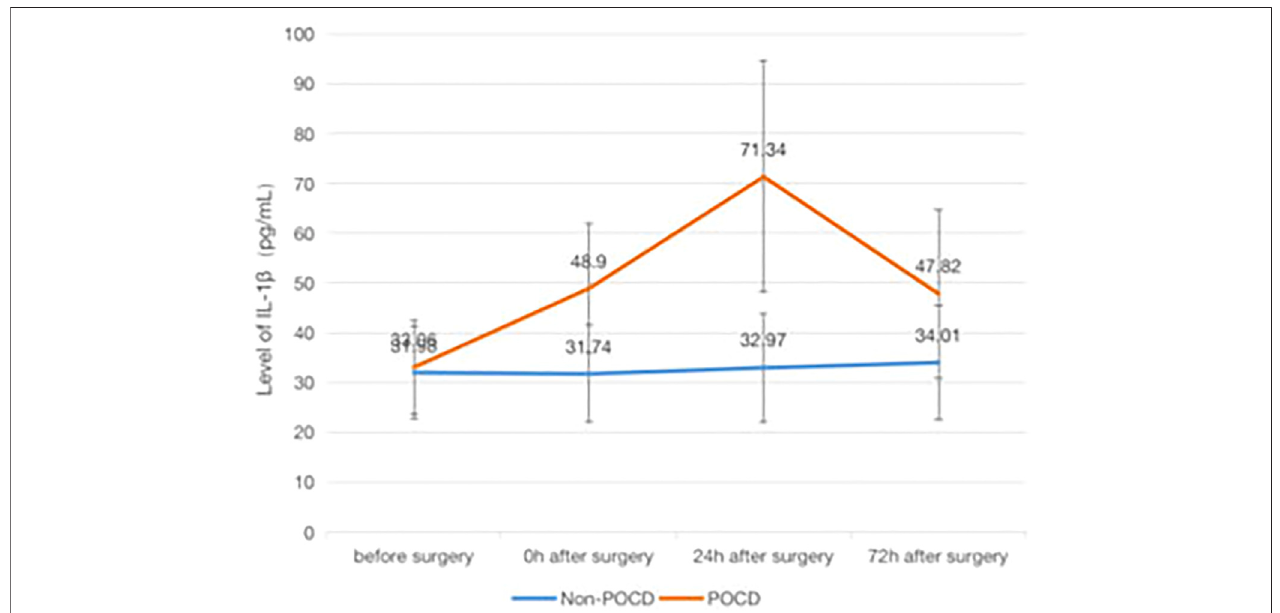
FIGURE 2 | Comparison of serum concentrations of IL-1 β (pg/ml) between Non-POCD and POCD groups before and after surgery 丨 There was no signi fi cant difference in the preoperative levels of IL-1 β concentration in the Non-POCD group compared with postoperative levels. There was no signi fi cant difference in the preoperative levels of IL-1 β concentration in the Non-POCD group compared with POCD group. Compared with preoperative levels, the levels at 24th and 72nd hours after surgeries in the POCD group increased with statistically signi fi cance. The differences in the levels of IL-1 β concentration between patients in the POCD and Non-POCD groups at the same time points postoperatively were statistically signi fi cant. Values are mean ± SD. n (cid:1) 61. * p < 0.05 vs. the preoperative level of S-100 β ; # p < 0.05 vs. the POCD